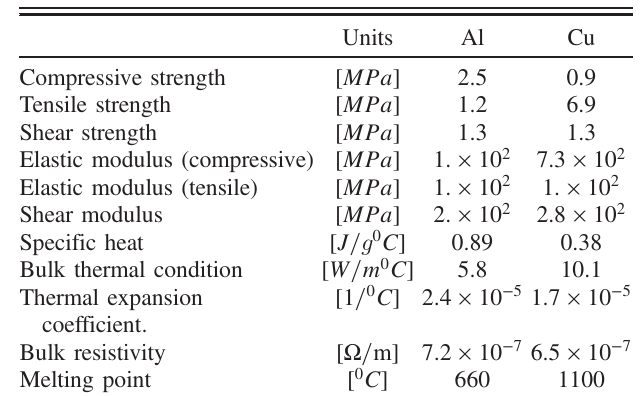
TABLE I. Structural properties of Al and Cu open cell metal foams from [10].